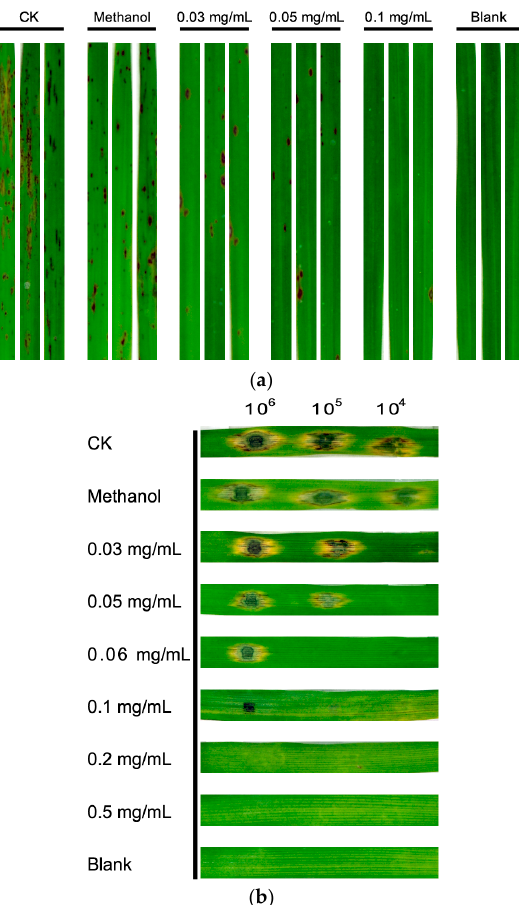
Figure 4. Effects of equol on the pathogenicity of Magnaporthe oryzae on rice and barley leaves. Conidia harvested from 10-day-old CM plates were re-suspended at 1 × 10 6 , 1 × 10 5 and 1 × 10 4 conidia/mL respectively. ( S )-equol was added to different final concentrations and methanol was supplemented to 2% in each treatment. ( a ) 14-day-old rice CO39 seedlings were inoculated with the 1 × 10 5 conidia/mL suspensions (CK) or the suspensions with different concentrations of ( S )-equol or with a methanol background and incubated at 28 ◦ C in darkness for 24 h and then in a 12 h light/12 h darkness cycle for 6 days; ( b ) Detached leaves of 7-day-old barley ZJ-8 were inoculated with the aliquots (20 µ L) of the suspensions with or without ( S )-equol or with methanol and incubated at 28 ◦ C in darkness for 24 h and then in a 12 h light/12 h darkness cycle for 3 days. The plants used as a blank control were inoculated with sterilized water in the same